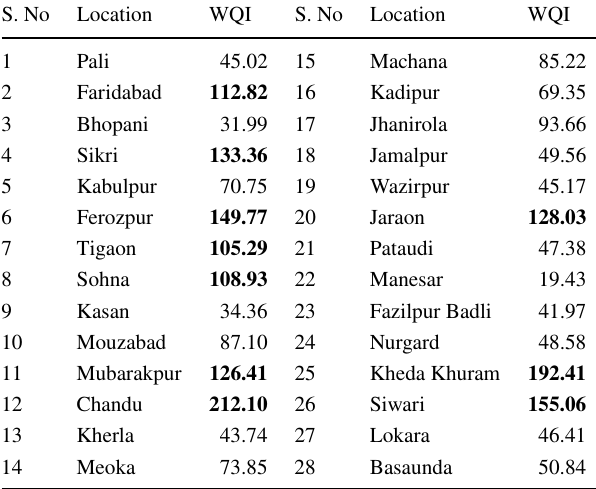
Table 6 WQI values of the 28 sites (WQI > 100 are unsuitable for drinking and are marked in bold)